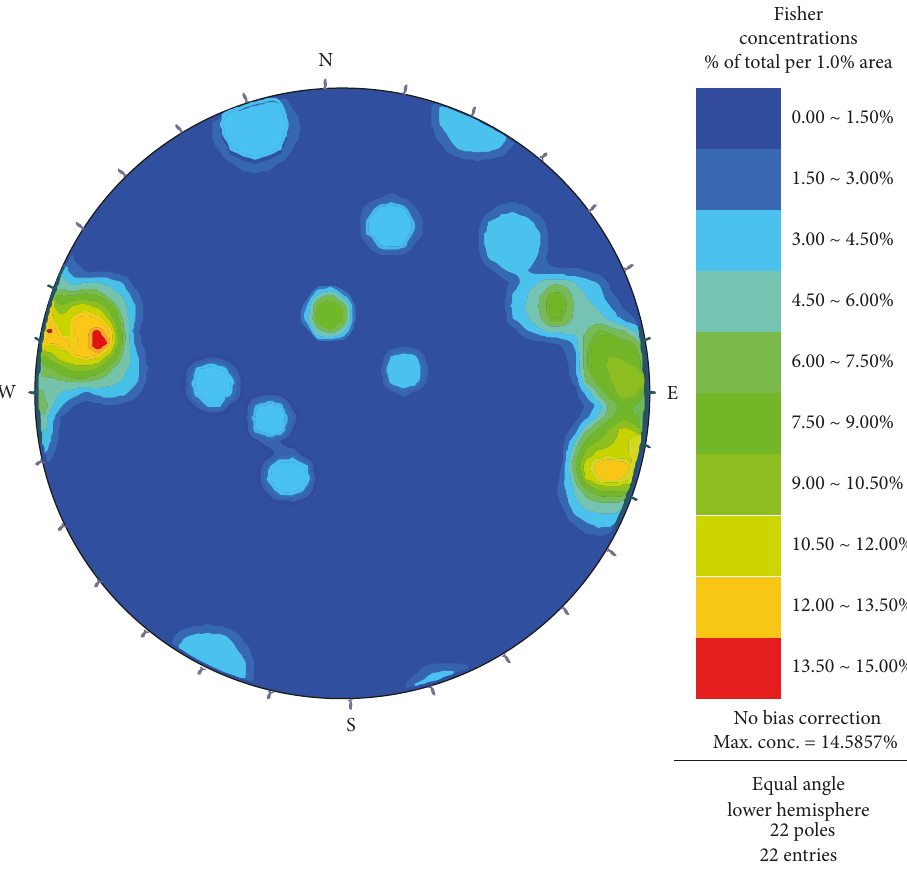
Figure 6: Statistical cloud chart of the structure surface.